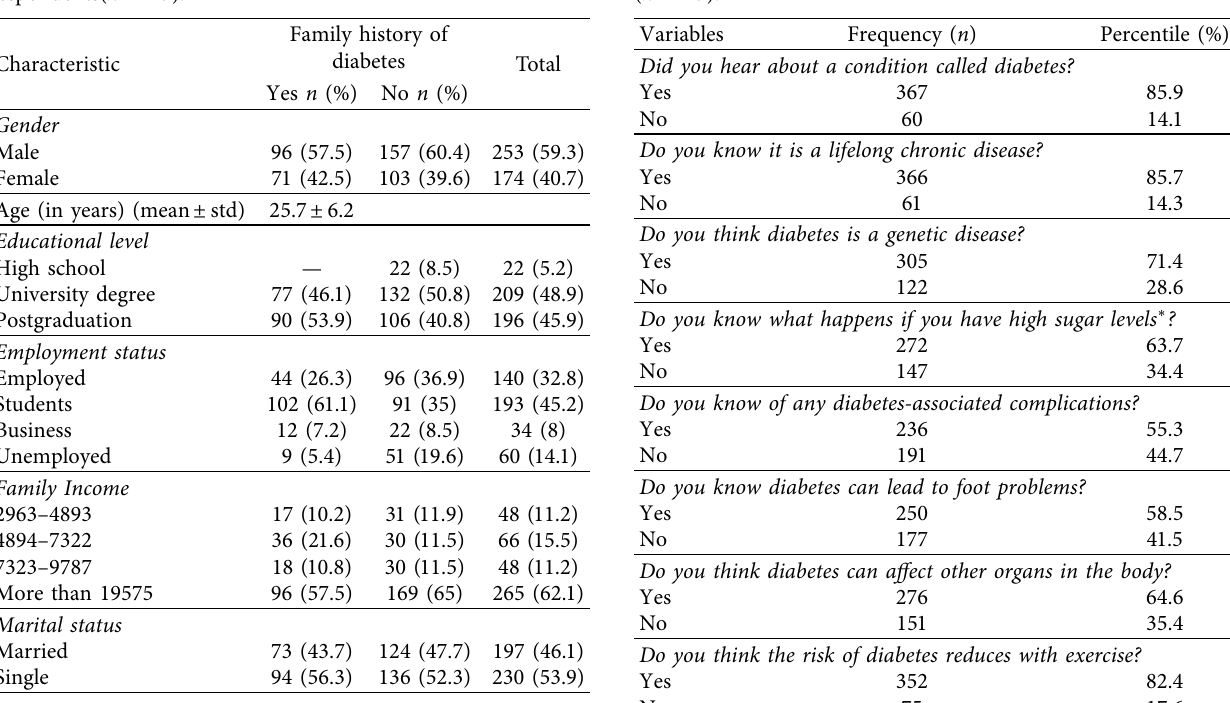
Table 1: Demographic characteristics Table 2: Diabetes awareness among the survey participants ( n �